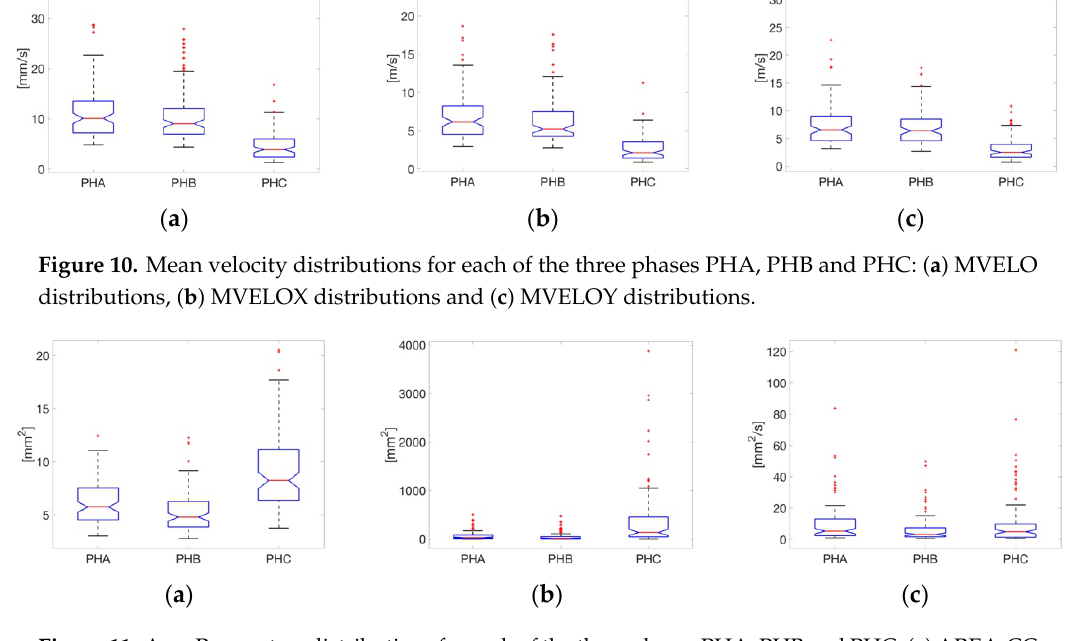
Figure 11. Area Parameters distributions for each of the three phases PHA, PHB and PHC: (a) AREA-CC distributions, (b) AREA-CE distributions and (c) SWAREA distributions.